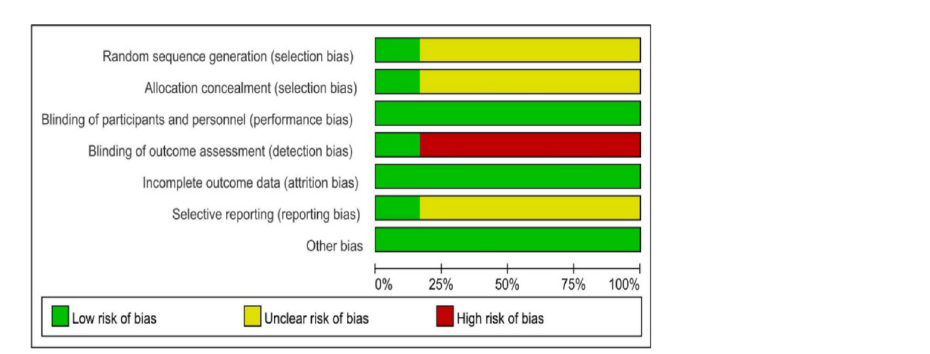
Fig 3. Graph depicting the risk of bias assessment.